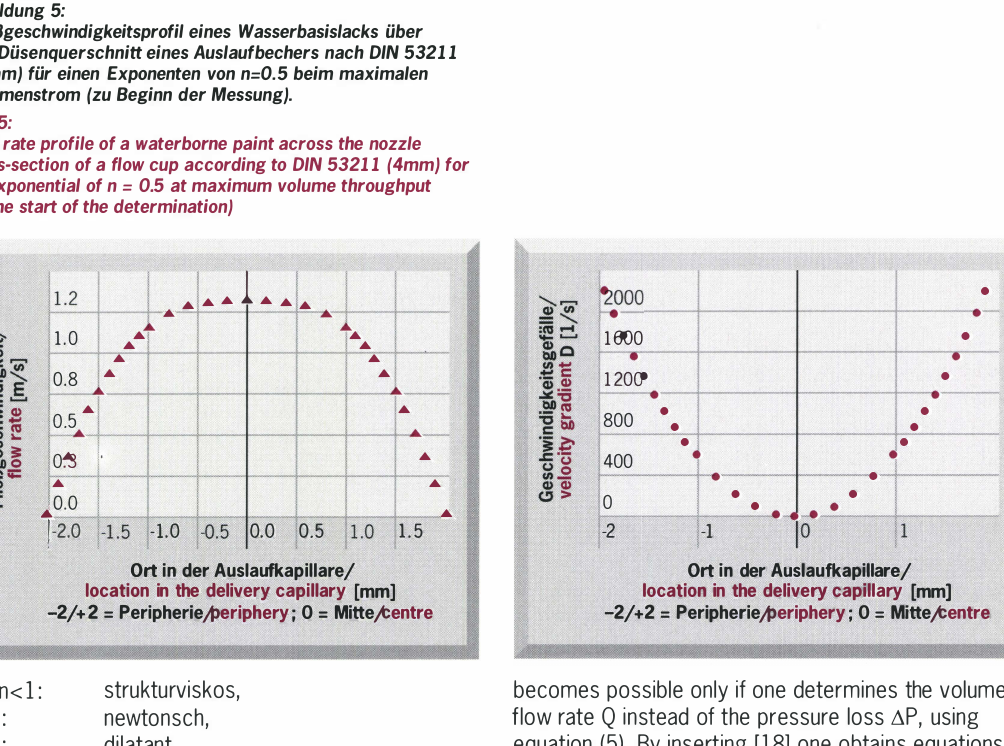
Fig. 6: Velocity gradient profile across the cross-section of a flow up according to DIN 53211 (4 mm) for a